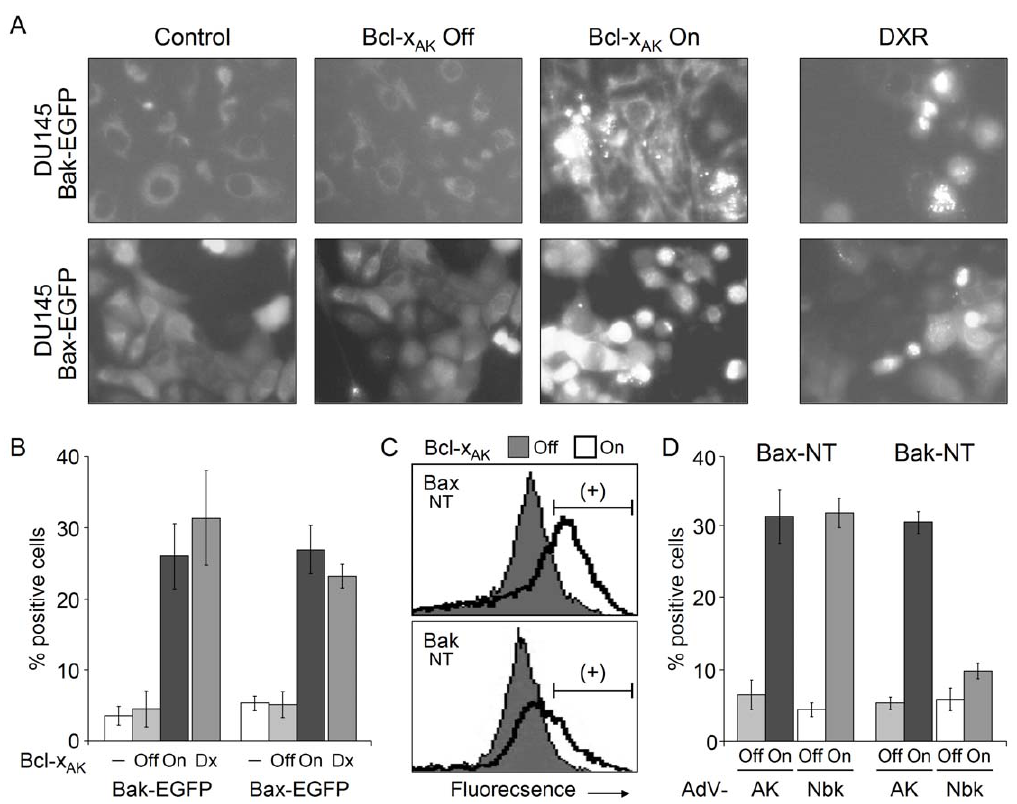
Figure 4. Bax and Bak activation after Bcl-x AK overexpression. (A) For investigation of Bax and Bak clustering, DU145 cells stably transfected for expression of EGFP-Bax or EGFP-Bak were transduced with AdV-AK and cultured for 48 h under OFF or ON conditions. Doxorubicin-treated cells (2 m M, 24 h) were used as positive controls. Examples of fluorescence microscope images taken at 48 h after transduction and promoter induction are shown. (B) A quantitative evaluation of Bax and Bak clustering was performed (means and SDs of triplicate values of a representative experiment). A second experiment revealed comparable results. (C) Bax and Bak activation upon Bcl-x AK expression was determined in Mel-2a at 48 after AdV-AK transduction (50 MOI), by flow cytometry after staining with conformation-specific antibodies against Bax and Bak N termini (Bax/Bak NT). The bars indicate the populations counted as positive for activated Bax and Bak, respectively. (D) A quantification of triplicate values (one experiment of two independent) is shown. Transduction with AdV-Nbk (50 MOI) is shown for